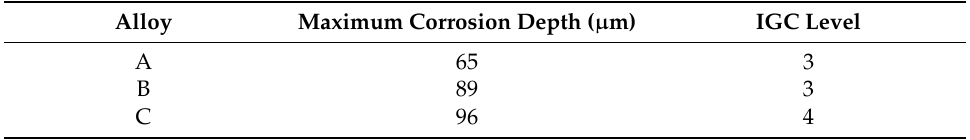
Table 3. Maximum IGC depths for the Al-Mg-Si alloys at peak-aged conditions.